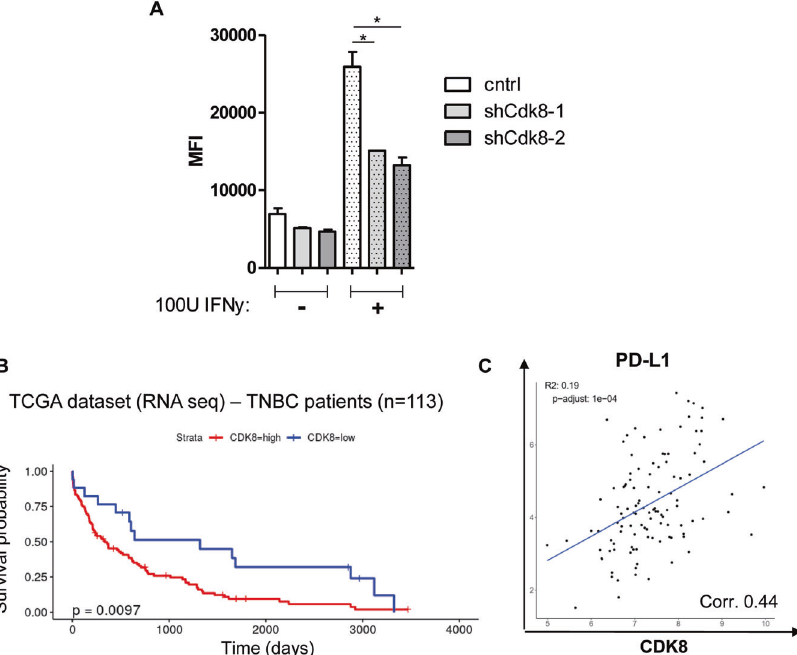
Fig. 6 CDK8 correlates with poor prognosis and with PD-L1 expression in a human dataset. A Median fl uorescence intensity (MFI) of PD-L1 expression of E0771 control, shCdk8-1, and shCdk8-2 cells, cultivated with or without 100 U/ml IFN γ for 48 h (indicated by “ − ” and “ + ” on the bottom of the graph); analyzed by fl ow cytometry. One representative experiment out of two is shown. Symbols and error bars represent mean ± SEM of technical duplicates. B , C Patient data from the TCGA database were sub-grouped in TNBC patients ( n = 113) and analyzed for ( B ) overall survival comparing CDK8-high- and CDK8-low-expressing patients and ( C ) correlation between CDK8 and PD-L1 expression in this human dataset of TNBC patients.